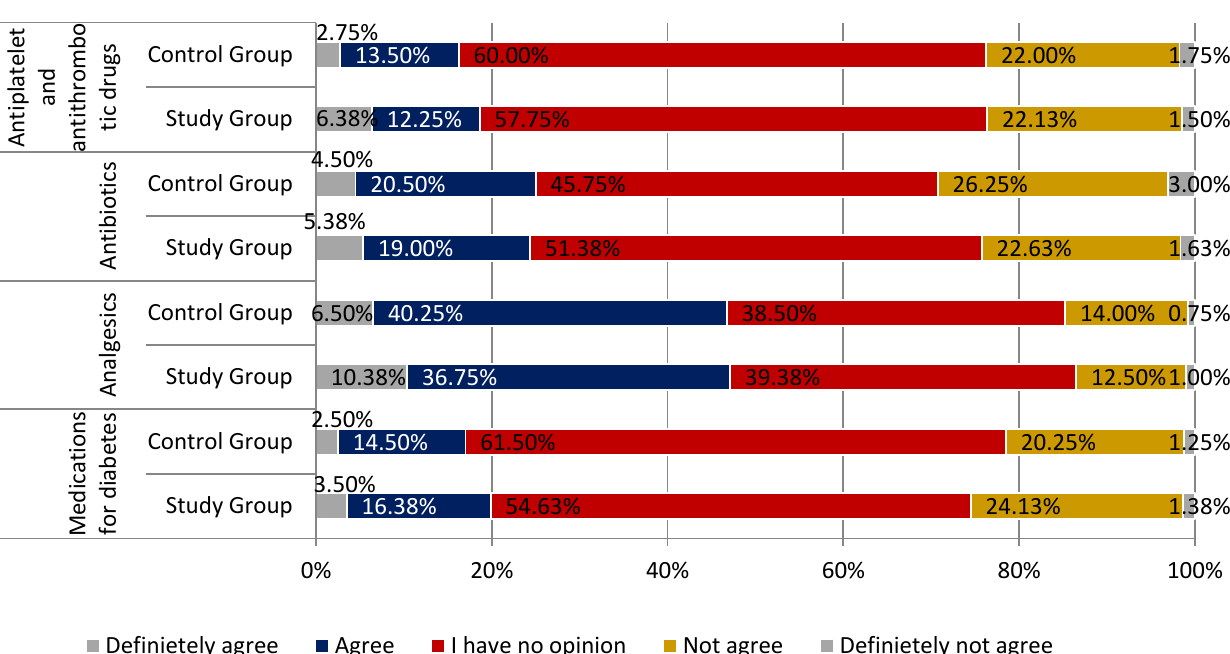
Figure 9. The most frequently falsified medicines in the opinion of respondents summary (part 2).